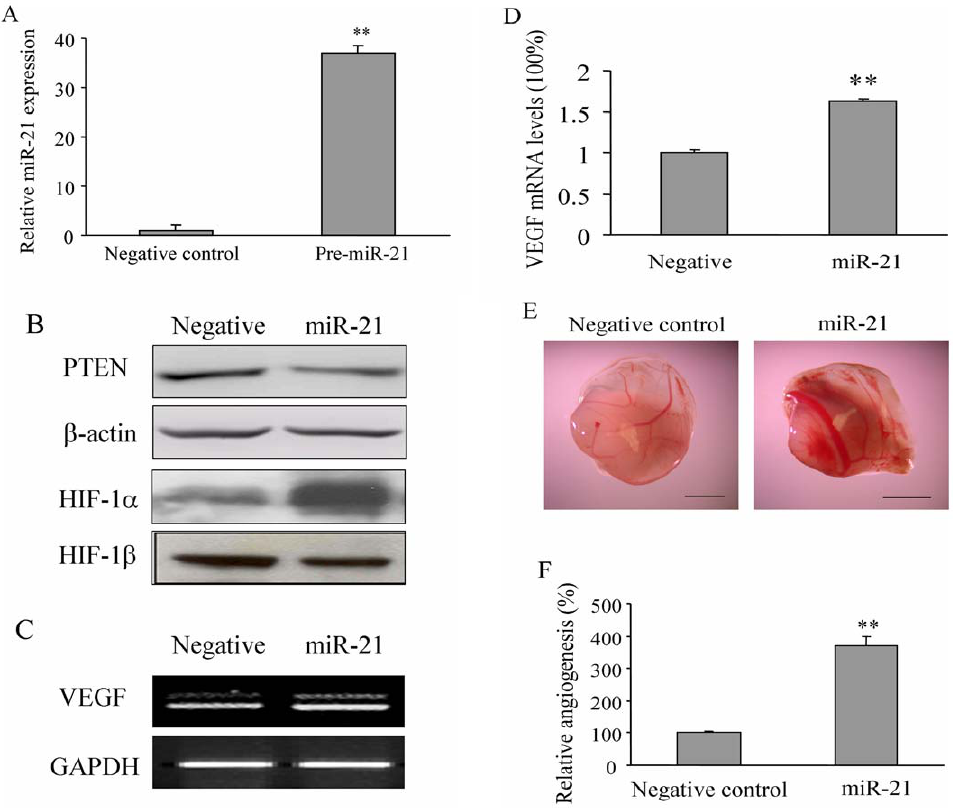
Figure 1. MicroRNA miR-21 overexpression increased HIF-1 a and VEGF expression and induced tumor angiogenesis. (A) Human prostate cancer cells DU145 were transfected with pre-miRNA negative control or pre-miR-21 at 25 nM. After the transfection for 36 h, cells were collected and subjected to qRT-PCR for miR-21 expression. (B) DU145 cells were treated as in A , the total protein was extracted and subjected to Western blotting assay. (C–D) DU145 cells were collected after the transfection for 36 h. Total RNAs were extracted and analyzed for VEGF and GAPDH mRNA expression by RT-PCR analysis (C), and by real-time RT-PCR (D). (E) DU145 cells were transfected as above. After 24 h, cells (2 6 10 6 cells, 15 m l) were mixed with 15 m l Matrigel. The cell mixture was implanted onto the CAM of a 9-day old chicken embryo. After 4 days of implantation, the CAM was cut off, and the amount of blood vessels on the CAM induced by the DU145 plugs was determined from eight different replicated experiments. Representative plugs from negative control and miR-21 treatment groups were shown. Scale , 2 mm. (F) The number of blood vessels were counted from replicate experiments, and normalized to that of the negative control group as relative angiogenesis. The data are mean 6 SD from 6 replicates. ** indicates the significant increase when compared to the pre-miRNA negative control ( p ,